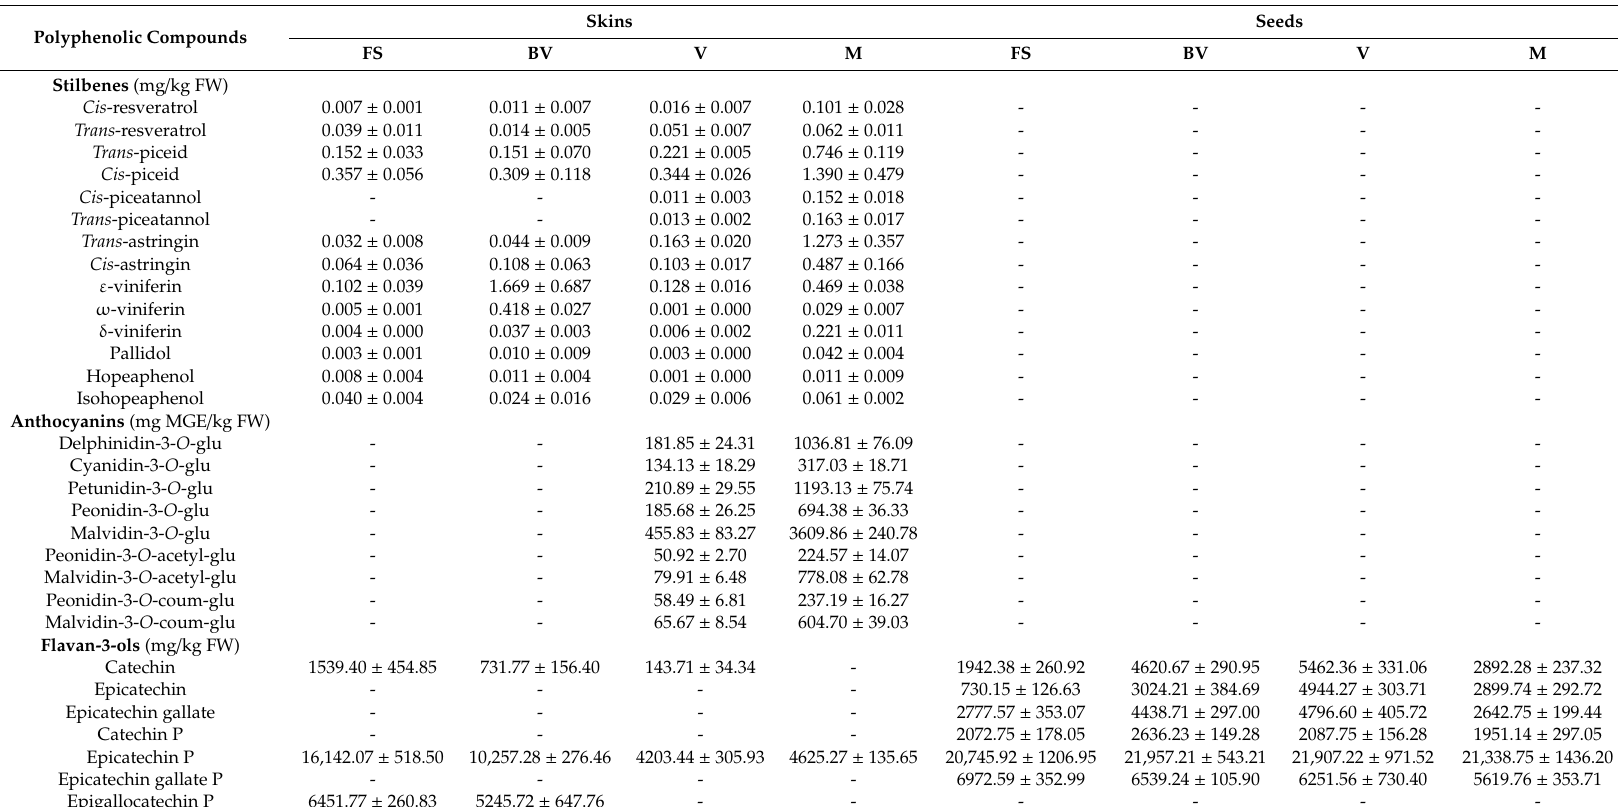
Table 2. Quantification of individual polyphenols of skin and seed Tannat grapes at di ff erent stages of ripening. All values are the mean of three biological replicates. Polyphenolic Compounds Stilbenes (mg / kg FW) Cis -resveratrol